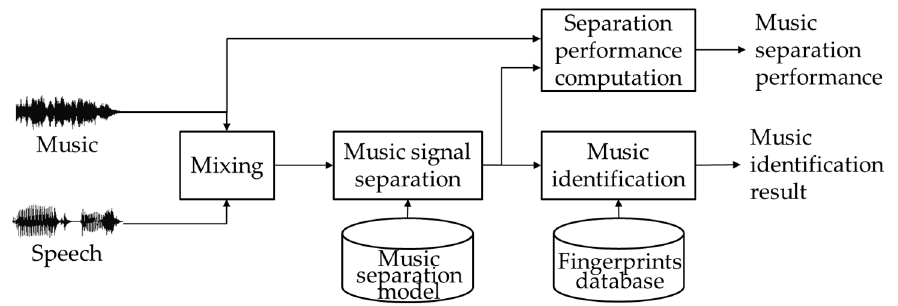
Figure 7. Structure of music identification after music signal separation.